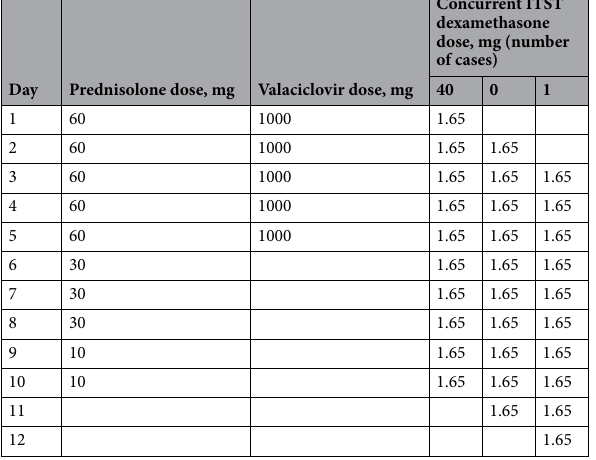
Table 1. Standard oral steroid and antiviral therapies and concurrent ITST dexamethasone dose. Doses of prednisolone and valaciclovir specified in the standard protocols for treating severe Bell’s palsy. In this study, intratympanic steroid therapy was initiated on day 1, 2, or 3 after onset of facial palsy. Top: numbers of patients who started concurrent ITST on each of day 1, 2, and 3. ITST, intratympanic steroid